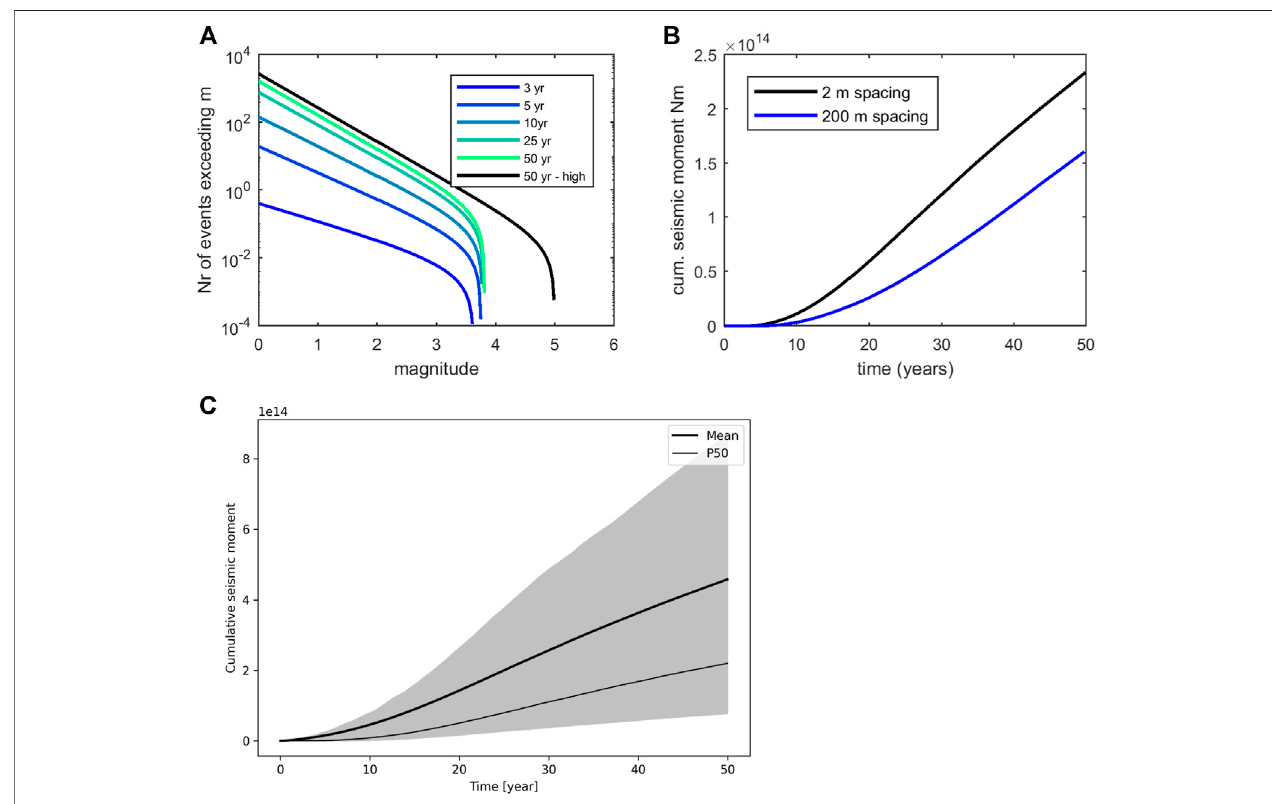
FIGURE9|(A) TemporalevolutionoftruncatedGutenberg-Richterfrequency-magnitudedistributionofseismiceventsfor2 mfracturedistance(singlerealization). Vertical axis shows number of events N ( M ≥ m ), i.e. the expectation value for the number of events with a magnitude ( M ) larger than or equal to m . Blue to green colors represents FMD in low-stress environment at different times after onset of injection, see legend. Black line presents FMD after 50 years of injection for the high-stress environment. Inputparameters forlow-stressenvironment: M min (cid:2) 0,b-value (cid:2) 1, Δσ (cid:2) 5.0 MPa.Input[ M min ,M max ] (cid:2) [0, 5.0]forhigh-stress environment.Dieterich seismicity parameters for this realization: A (cid:2) 0.001, _ τ 0 (cid:2) 0.002 MPa/yr, and r 0 (cid:2) 1; f crit (cid:2) 0.4. (B) Comparison of cumulative seismic moment release for both fracture distances in a low stress environment (single realization). Input parameters for this realization equal to values mentioned under Figure 9A . (C) Distribution of cumulative seismic moment release on the fault in densely fractured reservoir in a low stress environment, taking into account uncertainties in parameters. Shaded area shows cumulative seismic moment release between P10 and P90. Parameters fault dip (60 ° – 80 ° ), f crit (0.3 – 0.5), Δσ (0.1 – 10 MPa) and b-value (0.8 – 1.2). Values for other input parameters equal to values mentioned under Figure 9A .